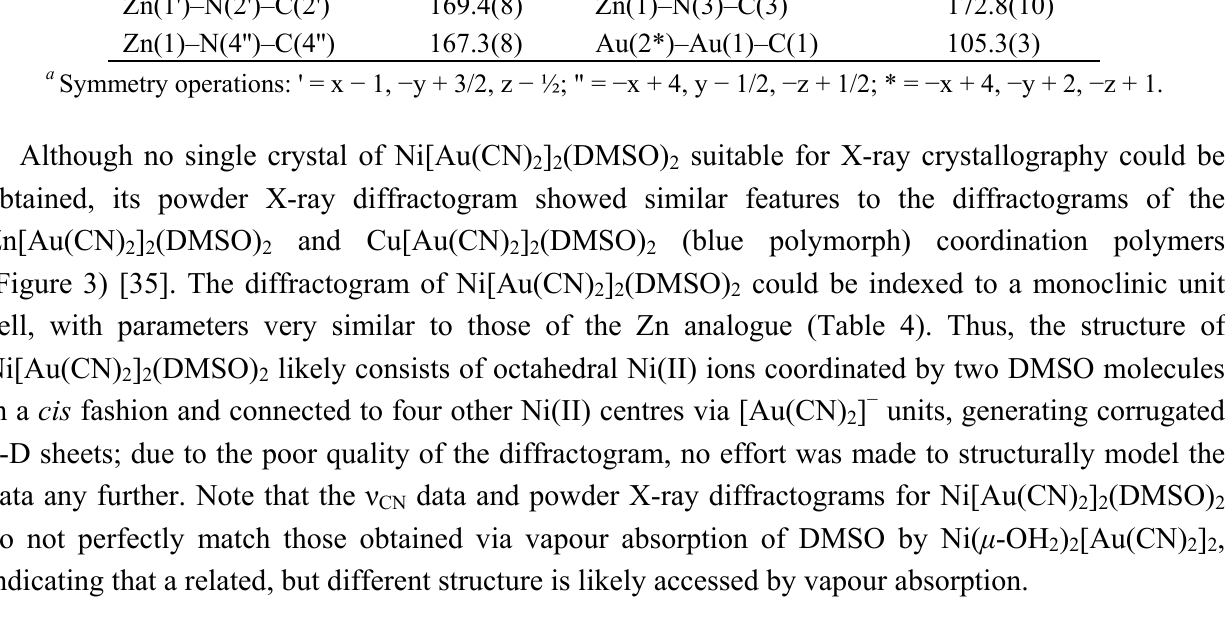
Figure 3. Comparison between the powder X-ray diffractograms predicted for ] (DMSO) (Zn, green) and the blue Cu[Au(CN) Zn[Au(CN) 2 2 2 blue), with the diffractogram obtained experimentally for Ni[Au(CN) orange), prepared via solution